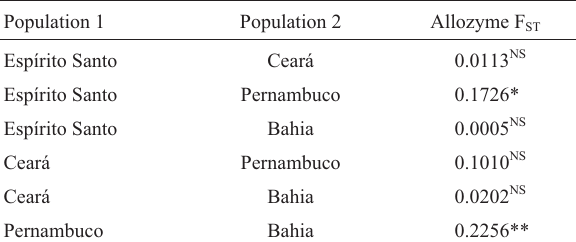
Table 4 - Pairwise F ST values among the four Brazilian populations for allozyme data. Probability values (H o : F ST = 0) were calculated by 1000 bootstrap permutations. NS = not significant; * = p < 0.05; ** = p < 0.01